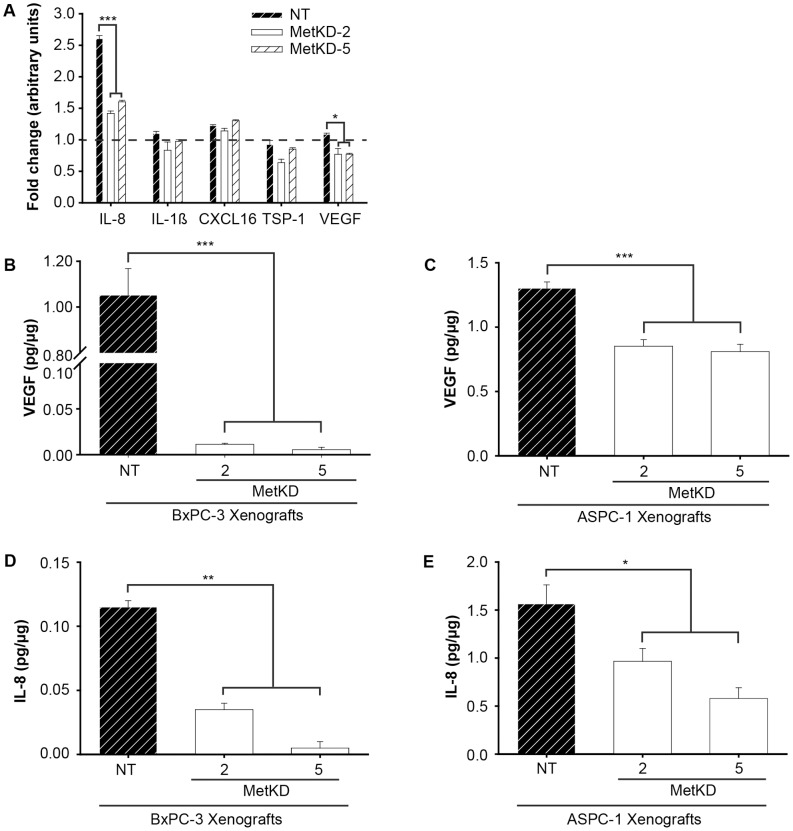
Met knockdown alters secretion of angiogenic factors.Conditioned media collected from ASPC-1 NT or MetKD cells treated with or without HGF (48 hr) was used to probe angiogenesis antibody arrays in duplicate. Data are presented as the fold difference of the indicated factor in response to HGF +/− SEM (*p<0.05, ***p<0.001; ANOVA) (A). VEGF ELISA shows decreased VEGF levels in BxPC-3 (B) and ASPC-1 (C) MetKD xenografts relative to NT control tumors (***p<0.001; ANOVA). IL-8 ELISA detected reduced IL-8 levels in BxPC-3 (D) and ASPC-1 (E) derived MetKD pancreatic xenografts compared to NT xenografts (*p<0.05, **p<0.01; ANOVA).